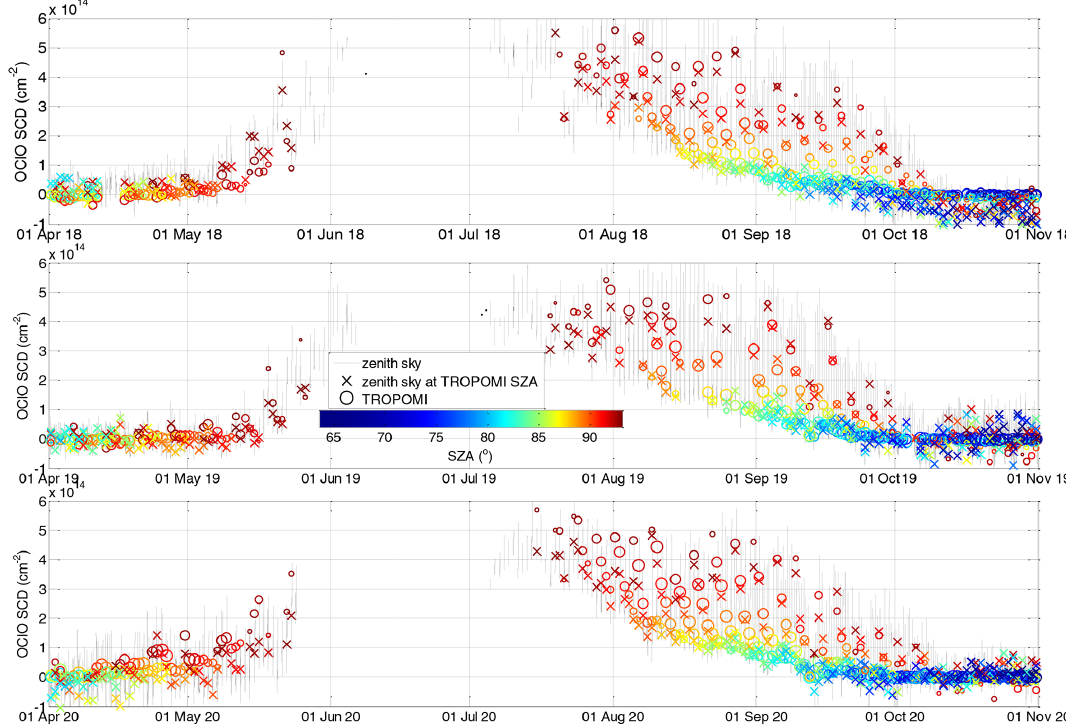
Figure 7. Same as Fig. 4 but for zenith sky OClO SCDs measured at Neumayer (70.64 ◦ S, 8.26 ◦ W).